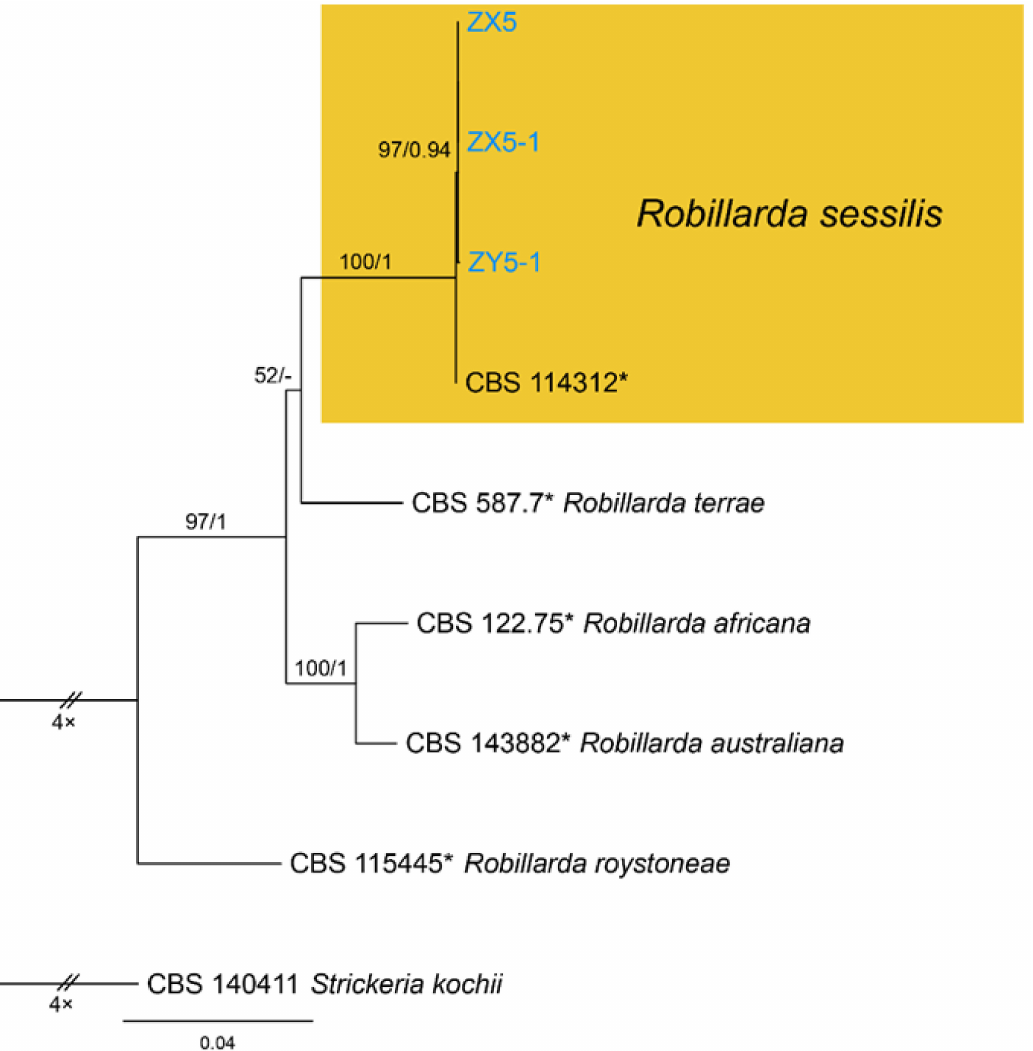
Figure A8. Phylogram generated from RAxML analysis based on combined ITS, LSU, rpb2 , tef1 and tub2 sequence data of Robillarda isolates. The tree was rooted to Strickeria kochii (CBS 140411). The scale bar indicates 0.04 nucleotide changes per site. Isolates from this study are marked in blue, ex-type strains are marked with *, and the identified species is marked in